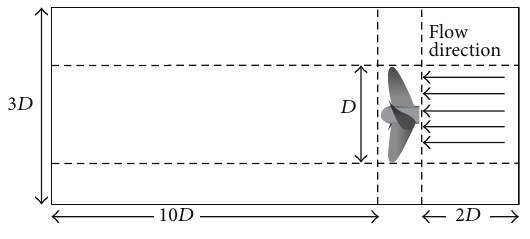
Figure 2: Numerical domain of